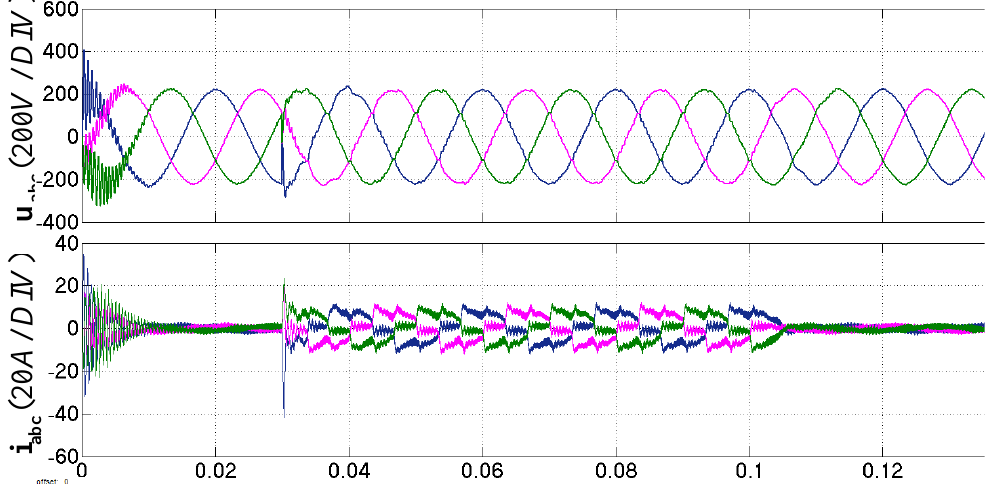
Figure 15. Simulation results of the propose control strategy with LCO under Scenario 3.